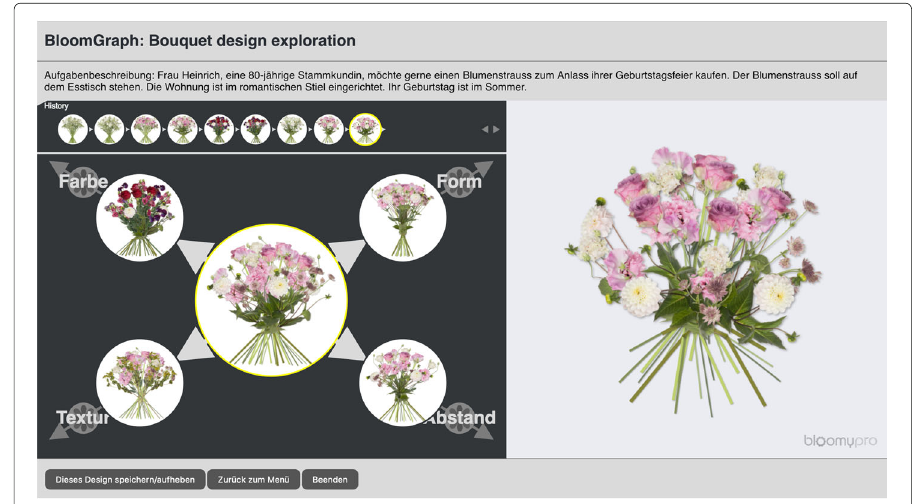
Fig. 1 A tool enabling future florists to explore the space of possible